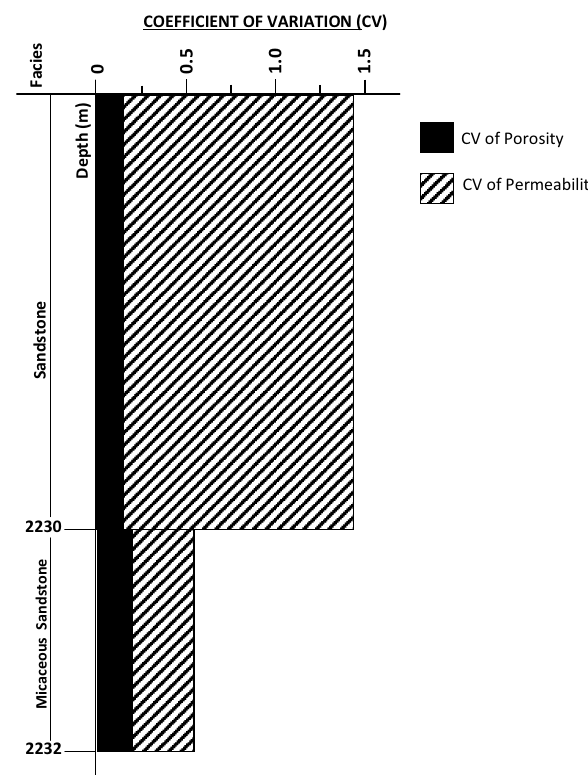
Fig. 4 Lithological log of selected cores at different depths in PZ-4 well Fig. 5